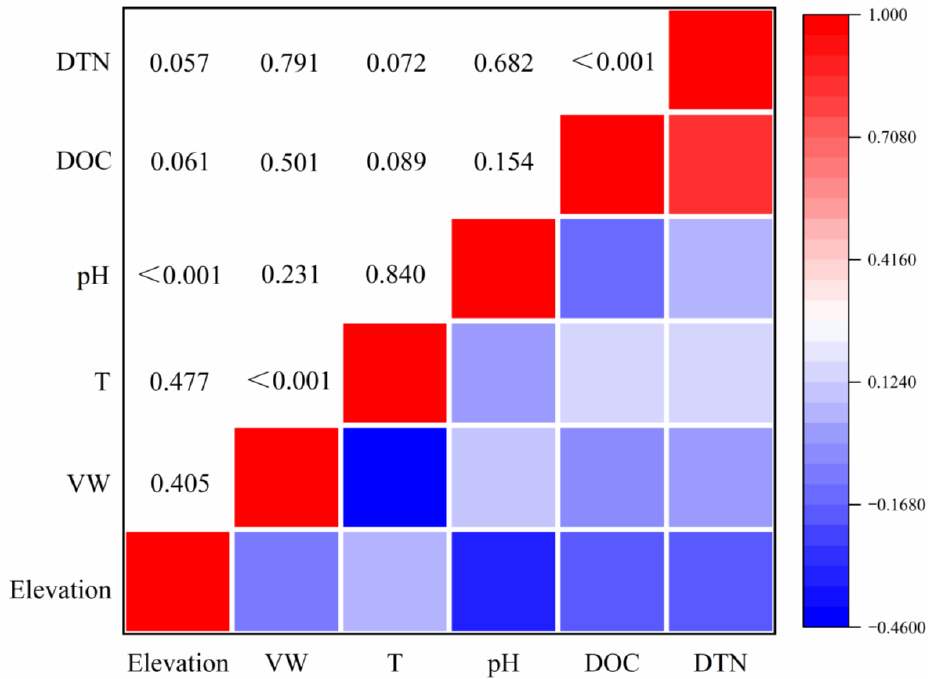
Figure 3. Spatial distribution of DOC and DTN estimated by ordinary kriging ( a , b ) and cokriging ( c , d ) across the study area.